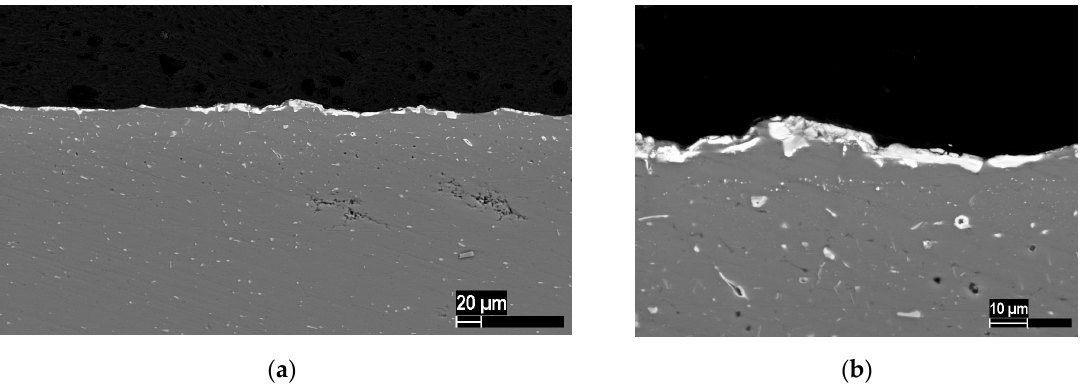
Figure 3. Microstructure of AA 6082 wetted with Al ‐ 40.0Ge ‐ 3.4Si wt.% filler alloy according to 540 °C/10 min mode, obtained by SEM at various magnifications: ( a ) 500× magnification; ( b ) 1000× magnification.